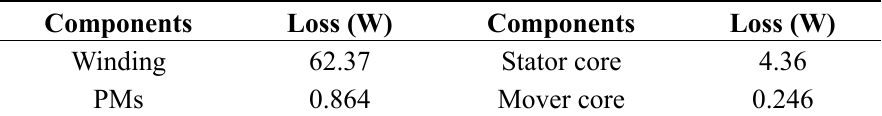
Table 6. Losses in the TFPMLM.